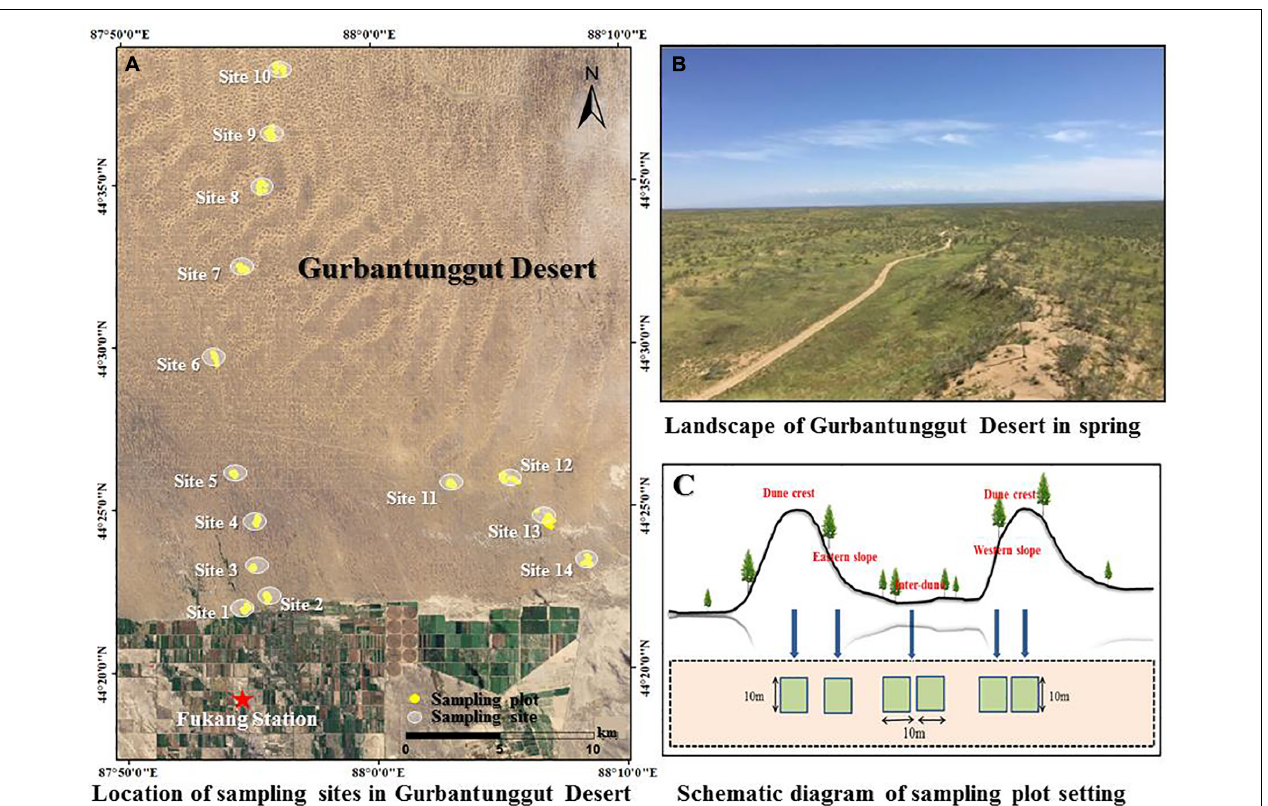
FIGURE 1 | Landscape (A,B) and sampling diagram (A,C) of the study